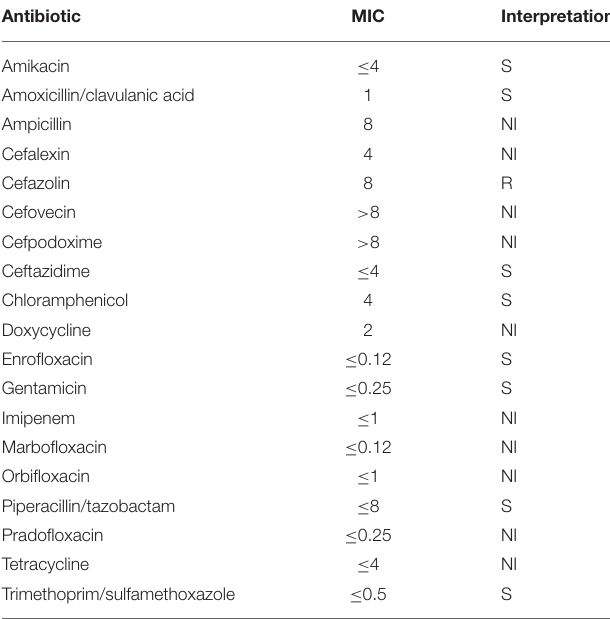
TABLE 1 | Antimicrobial sensitivity for Achromobacter xylosoxidans ss denitrificans from pleural and pericardial effusion, pericardium, and mediastinal